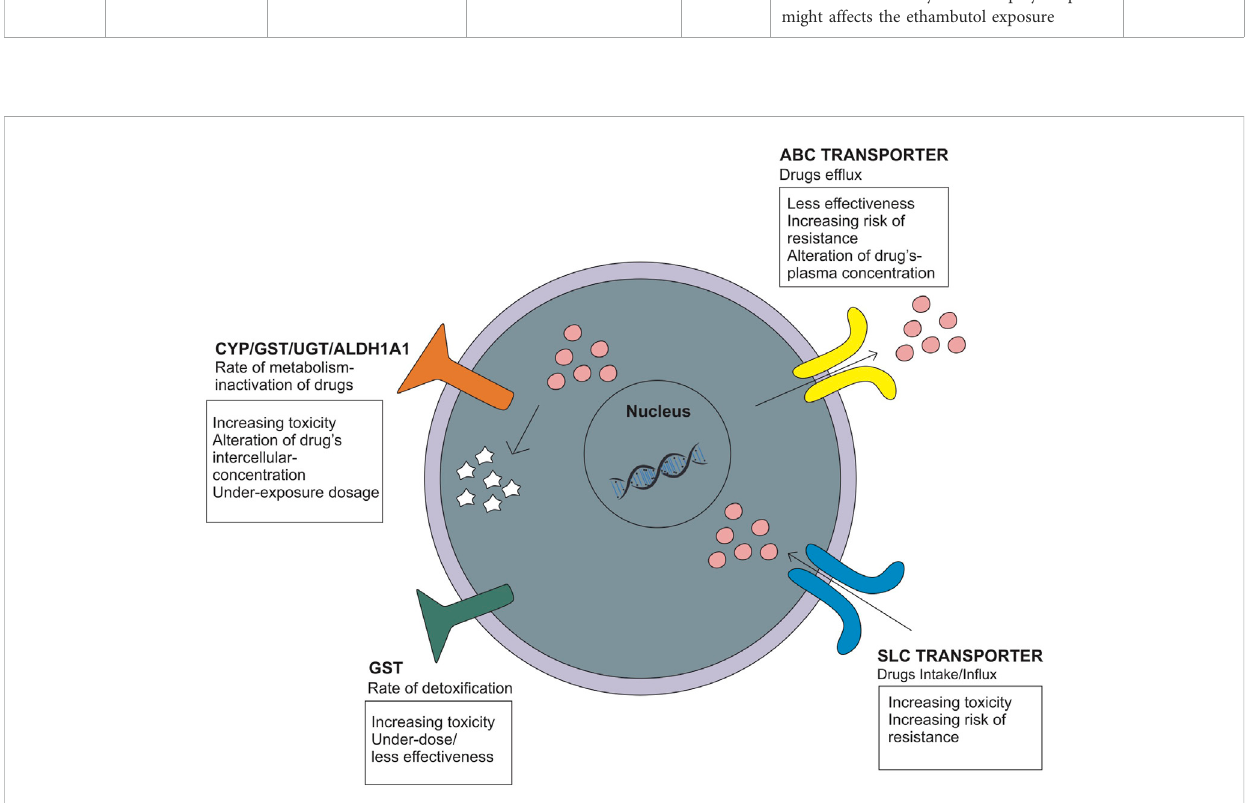
FIGURE 3 Genetic polymorphisms related to the pharmacokinetic mechanism that in fl uences the drug intake/ef fl ux and the rate of drug